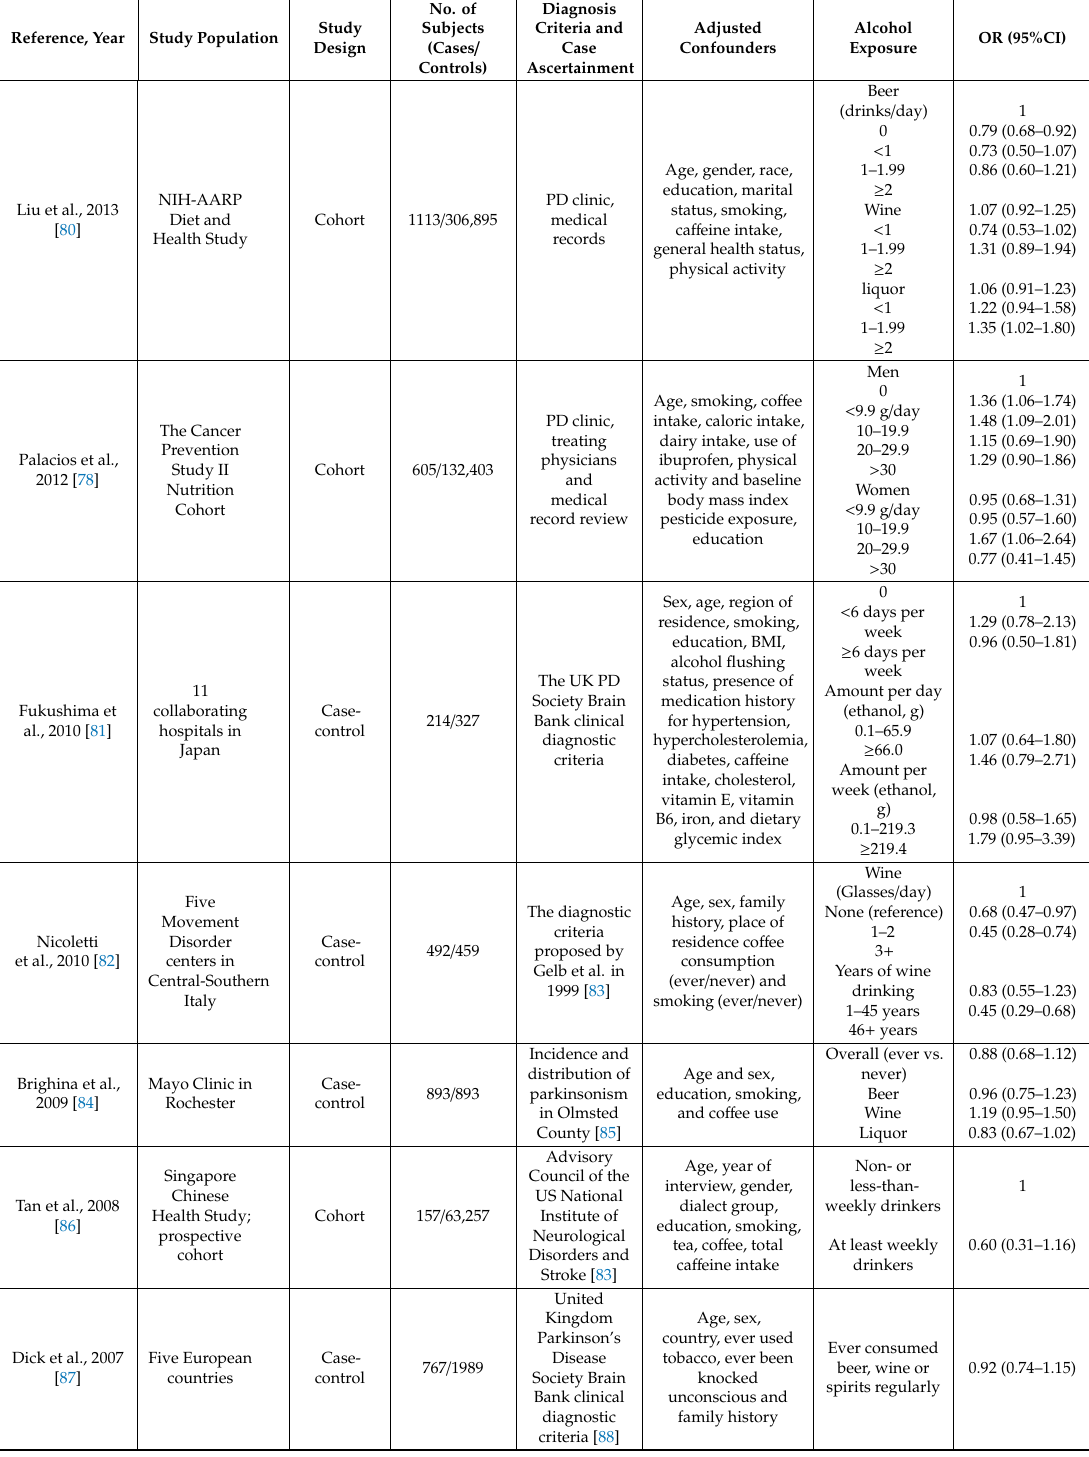
Table 3. Evidence-based studies on the relationship between alcohol and